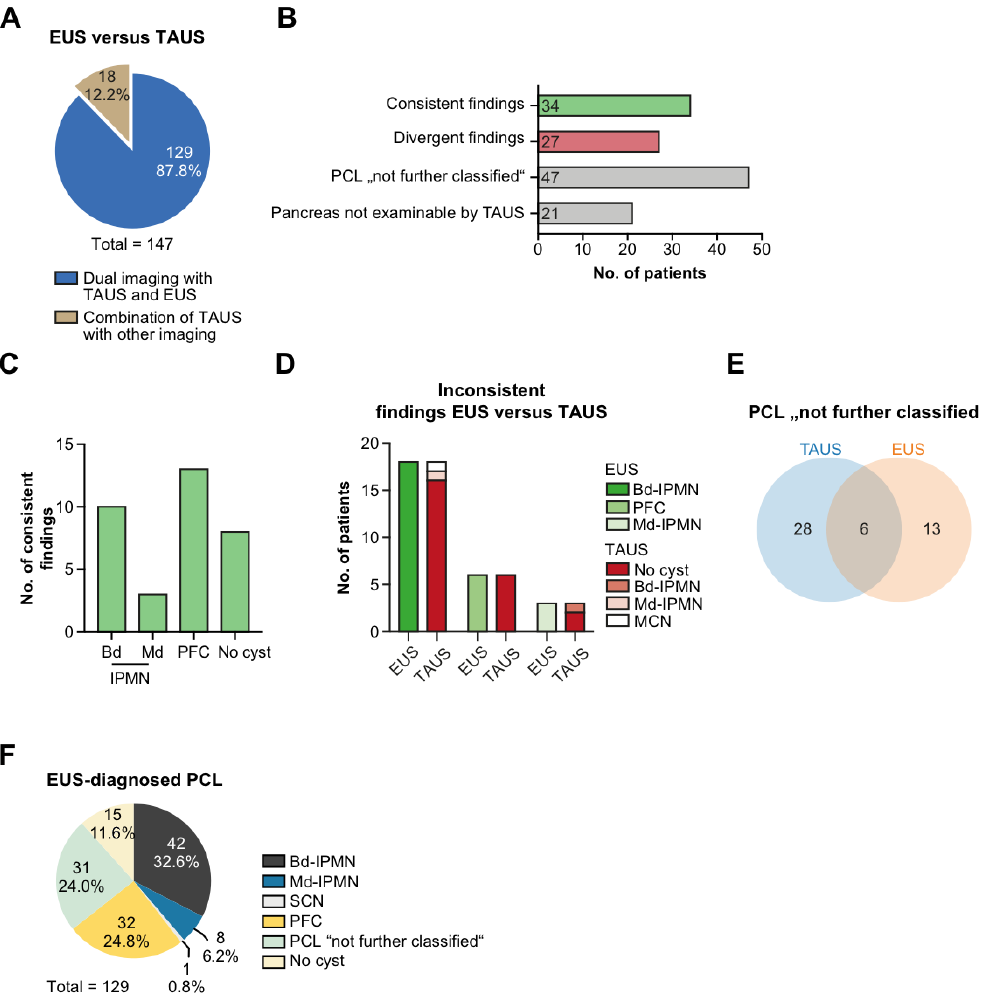
Figure 3. Diagnostic accordance between TAUS and EUS. ( A ) Patients with dual imaging combining TAUS with EUS or other type of imaging; ( B ) Patients (in absolute numbers) with EUS and TAUS assigned to the categories “consistent findings”, “divergent findings”, “PCL not further classified”, and “Pancreas not examinable by TAUS”. ( C ) Distribution of consistent findings. ( D ) Inconsistent findings between TAUS and EUS. ( E ) Venn diagram: non-classifiable PCLs on TAUS and EUS. ( F ) Di- agnostic categorization of PCLs evaluated by EUS (in absolute numbers). Transabdominal ultrasound, TAUS; endoscopic ultrasound, EUS; intraductal papillary mucinous neoplasm, IPMN; main duct type-IPMN, md-IPMN; branch duct type-IPMN, bd-IPMN; mucinous cystic neoplasm, MCN; serous cystic neoplasm, SCN; post-pancreatitis fluid collection, PFC; pancreatic cystic lesion,